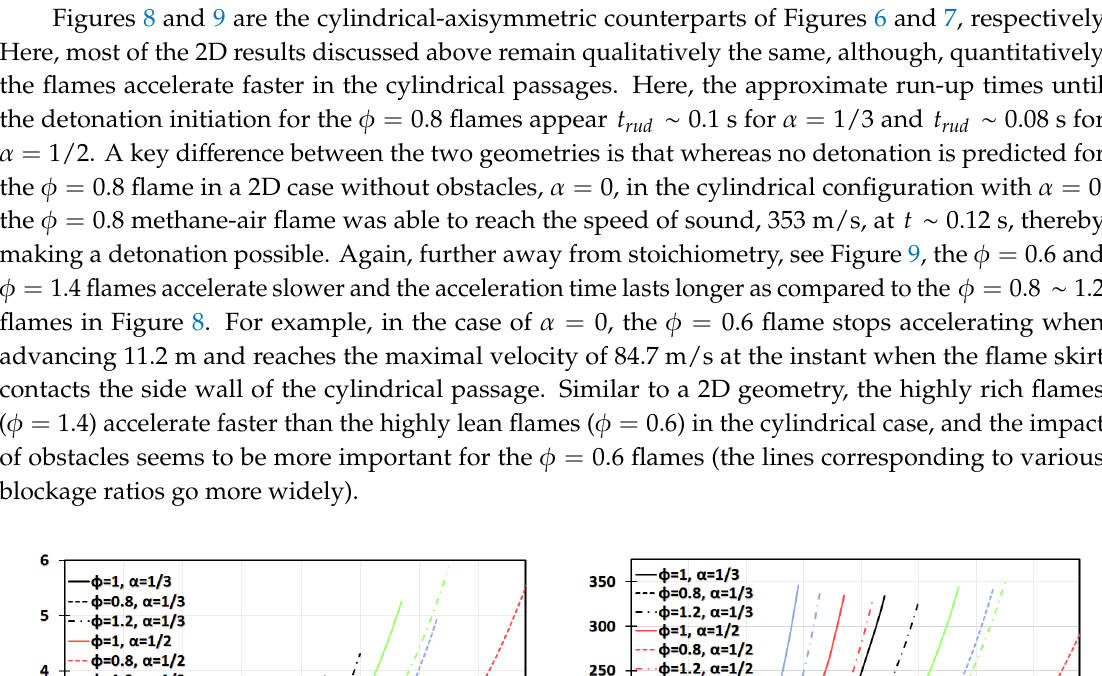
Figure 7. Time evolution of the flame tip position Z tip ( a ) and velocity U tip ( b ) in a 2D geometry for highly-lean ( φ = 0.6) and highly-rich ( φ = 1.4) CH 4 -air burning with various blockage ratios α = 0,1/3,1/2,2/3.